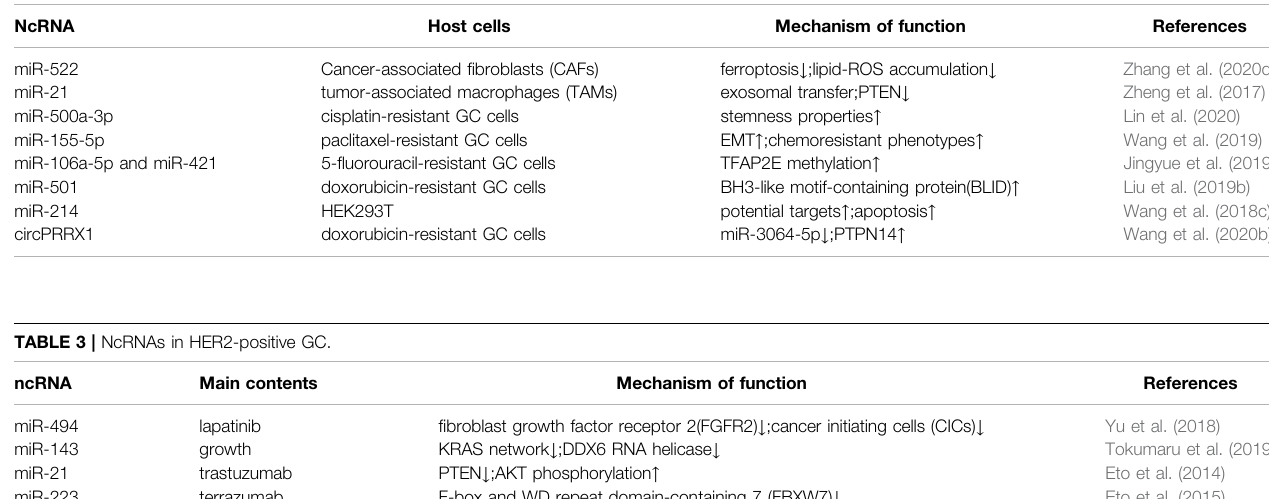
TABLE 2 | Exsomes ncRNAs AND drug resistance.